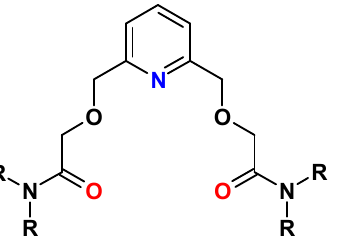
Figure 11. N,N,N′,N′ tetra-isobutyl pyridine diglycolamide (PDGA) (R = iBu).